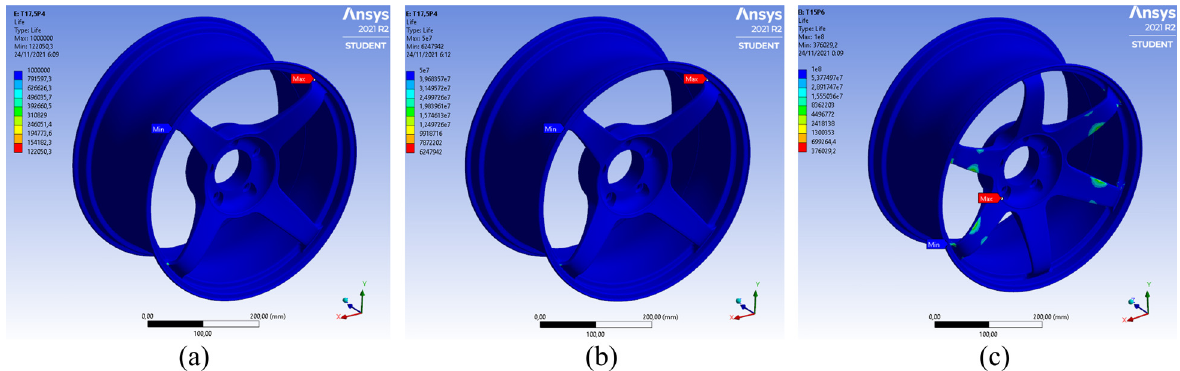
Figure 8: Variations of the rim wheel that experienced fatigue failure in the form of cracks: ( a ) SAP4T17.4; ( b ) MAP4T17.5; and ( c ) AAP6T15.